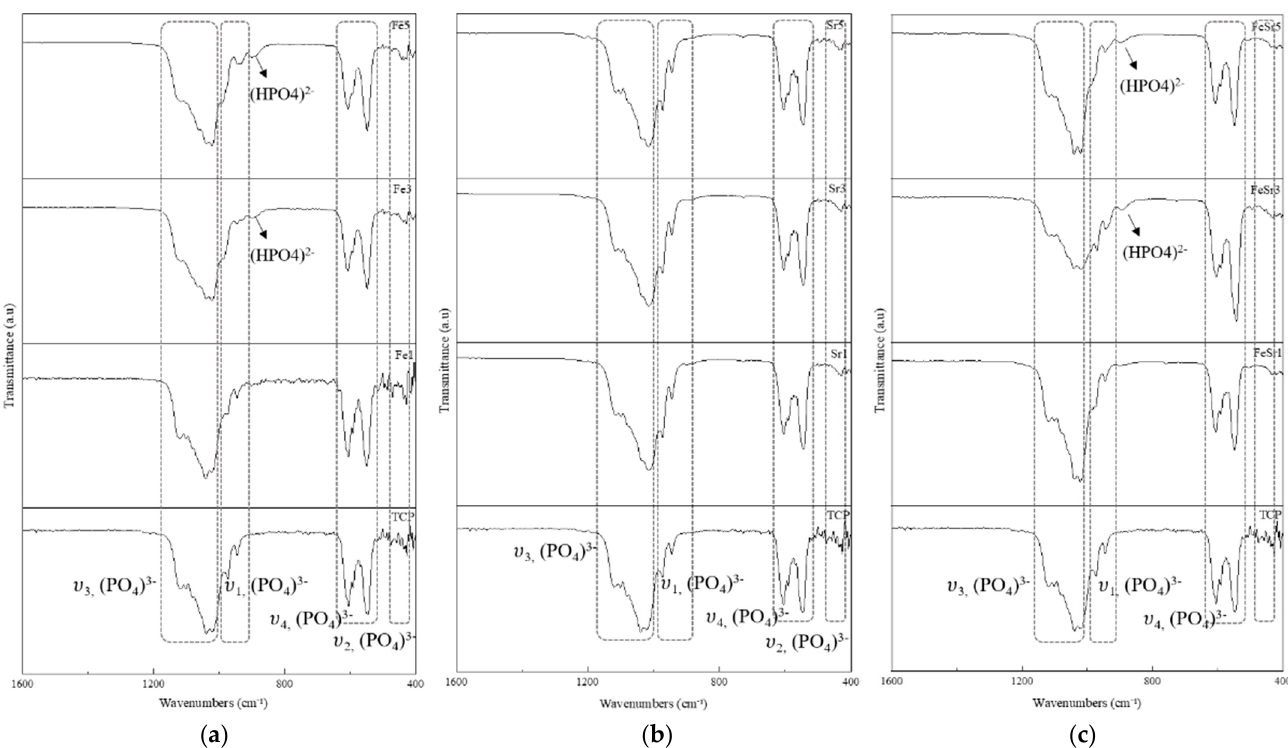
Figure 5. FT − IR spectra of various β− TCP powders with: ( a ) Fe − substituted samples, ( b ) Sr − substituted samples, ( c ) Fe/Sr co − substituted samples.